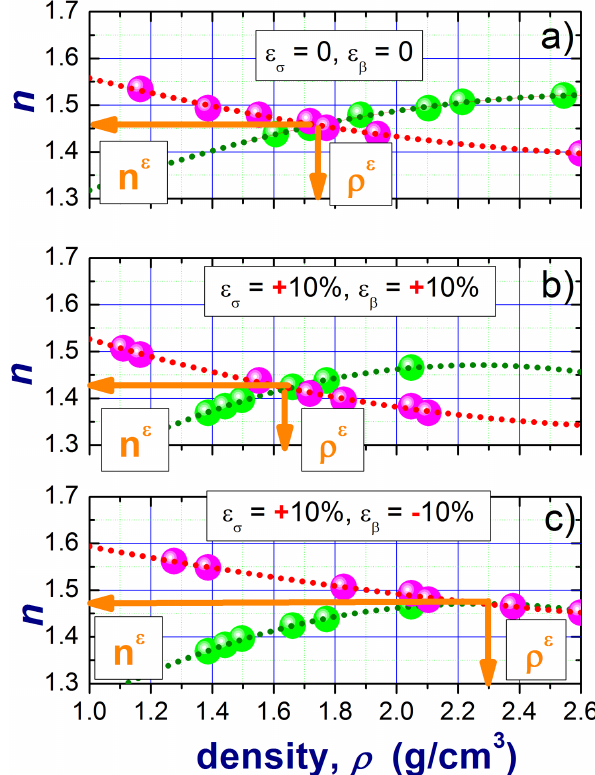
Figure 3. Schematic illustration of retrieving aerosol characteristics for three cases: (a) “error-free” conditions when the observational errors ( ε σ and ε β ) are zero, (b, c) “noisy” conditions when the ob- servational errors are positively (b) or negatively (c) correlated. The family of green points is an isoline of the assumed scattering coef- ficient at a given time, and, in a similar vein, the magenta points represent an isoline of the assumed backscatter fraction. The cor- responding polynomial fits (dotted lines with blue and red colors) ) . This illustra- are used for obtaining the solution ( n ε and ρ ε mod mod tion represents the error-free and noisy conditions from Fig. 2c and d for a given instant (Time = 2). Note that the crossing isolines are related to the 2-D diagrams of σ s , mod and β mod (e.g., Fig. 1b, c) calculated for assumed n and ρ